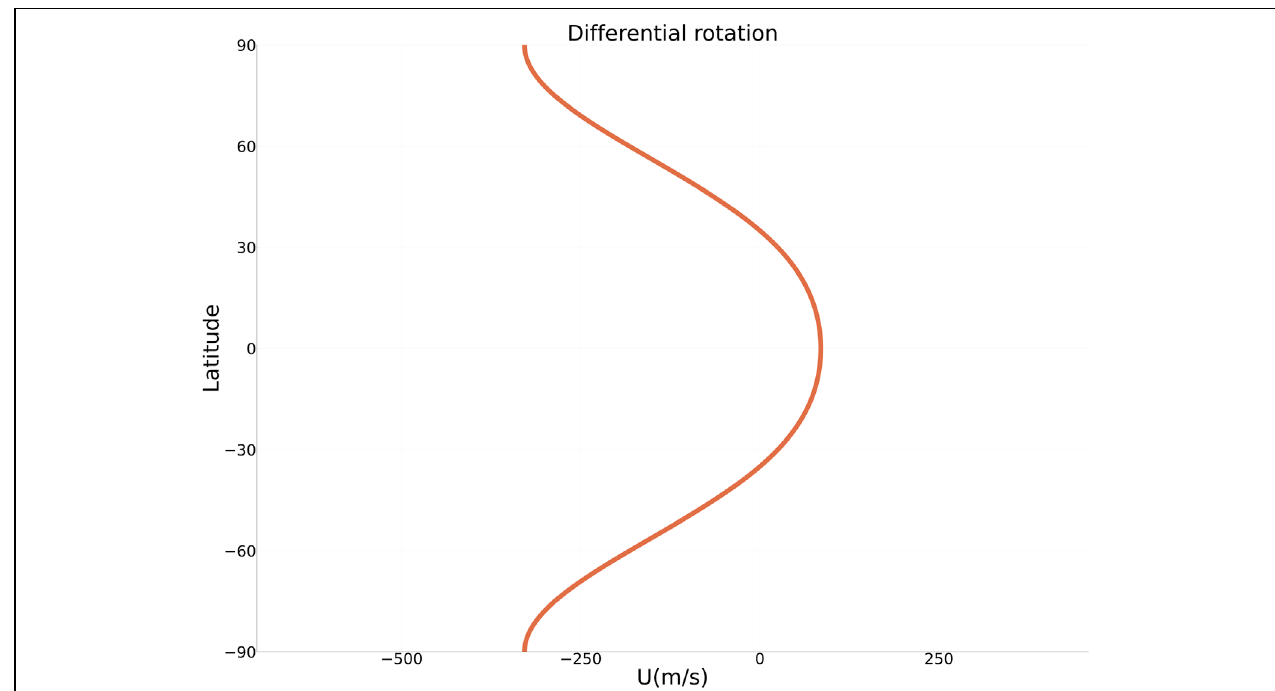
FIGURE 2 | Mean zonal flow profile used in this study, mimicking the solar differential rotation profile.